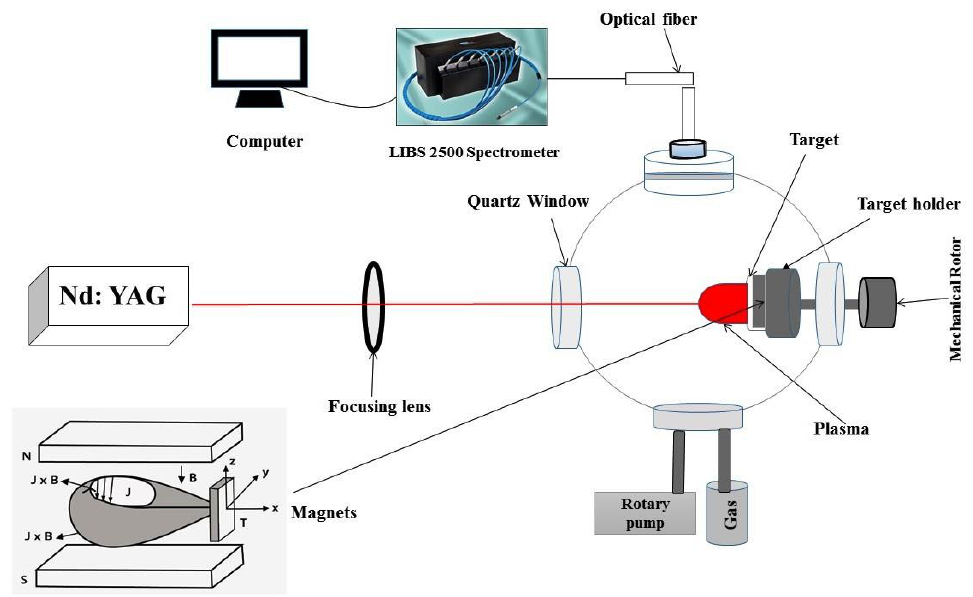
Figure 1. An experimental setup for studying the effect of TMF on the LIBS of Cu-alloy plasma generated with a Nd: YAG generated with a Nd: YAG laser.